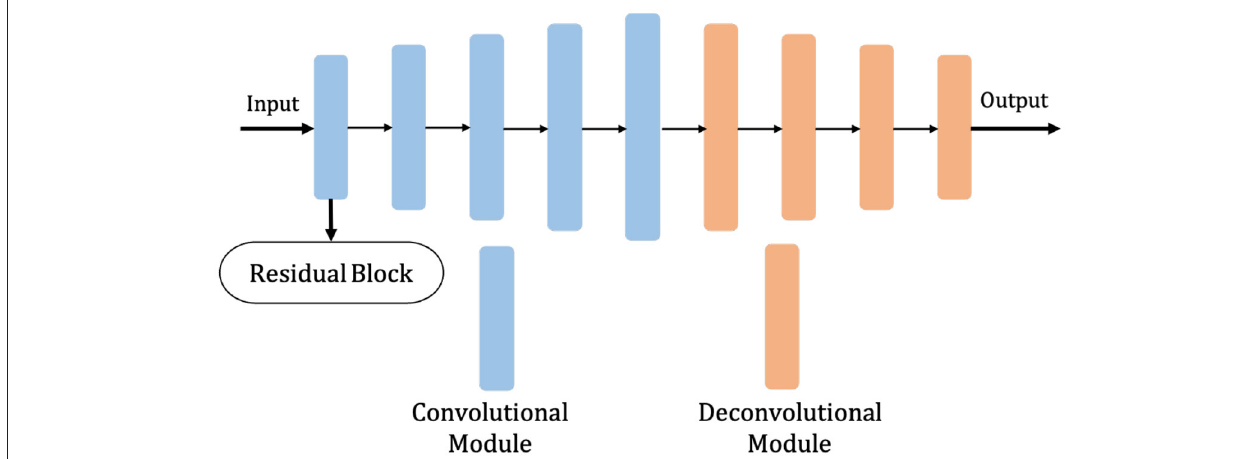
FIGURE 5 | Dense-ResUNet model framework diagram.